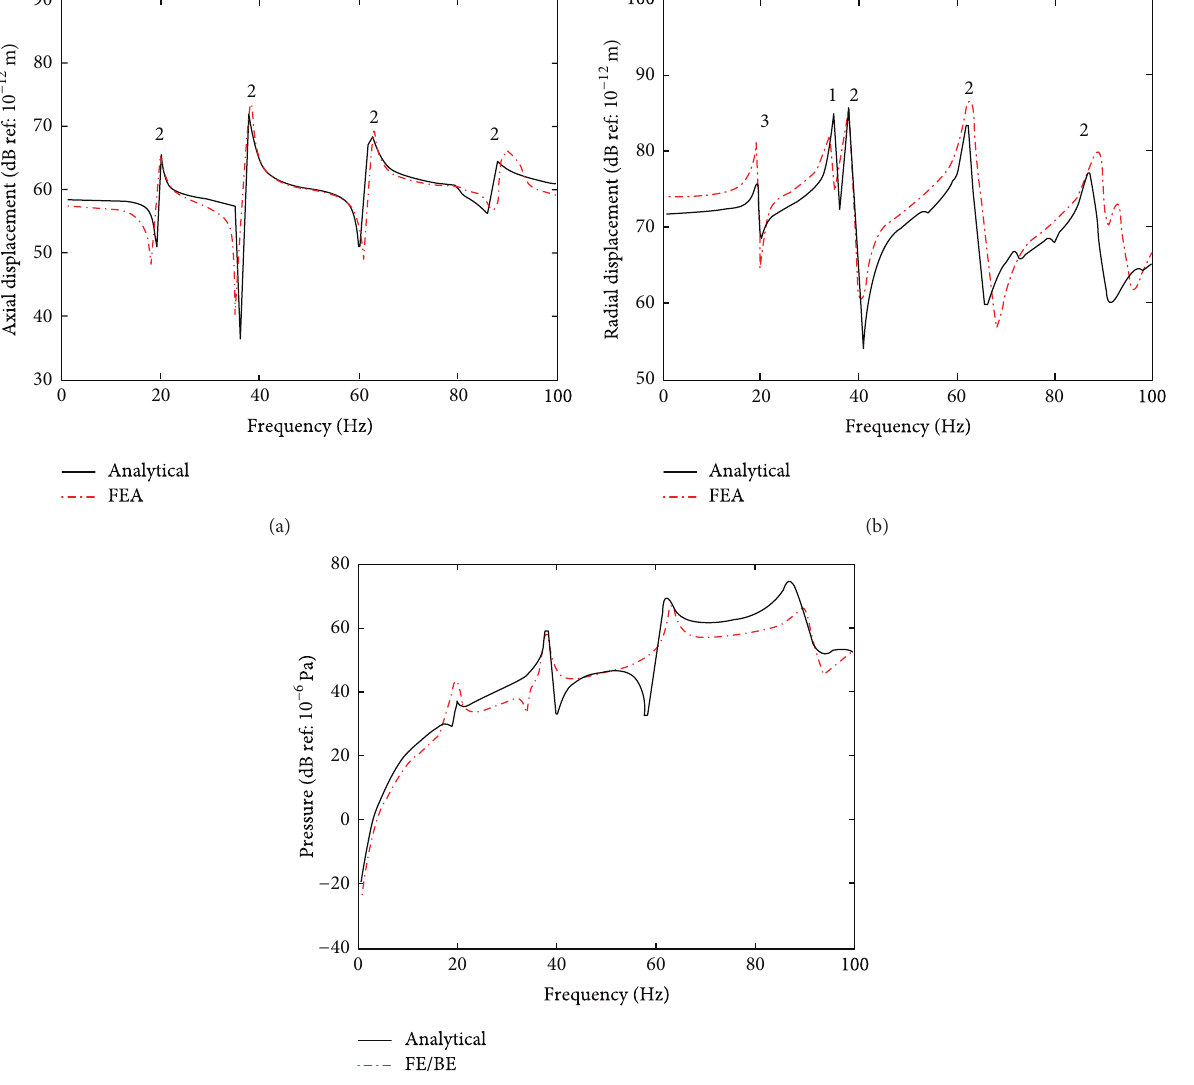
is introduced using complex Young’s modulus 𝐸(1 − 𝑗𝜂 𝑠 ) , where 𝜂 𝑠 = 0.02 is the structural loss factor. The surrounding fluid has a density of 𝜌 𝑓 = 1000 kgm 𝑐 = 1500 ms −1 . The structural responses are predicted at 𝑓 a point equal to the drive point of the excitation, as